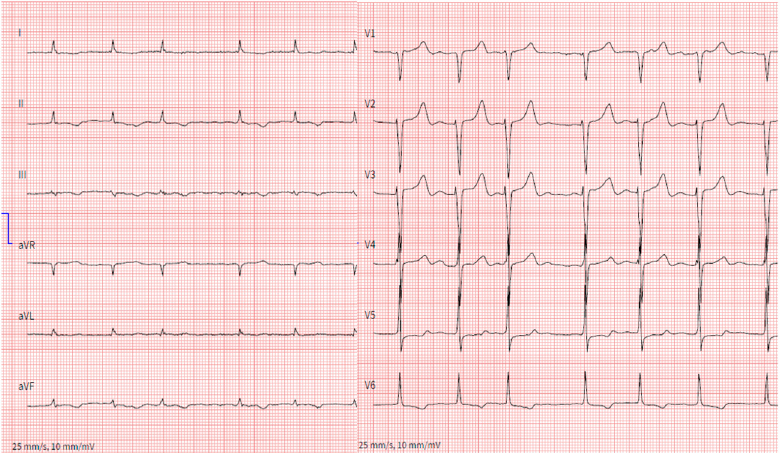
Figure 4. 12-lead surface ECG of a 73-year-old male patient with wtATTR, low voltages on extremity leads and atrial fi brillation with a mean heart of 75 bpm.